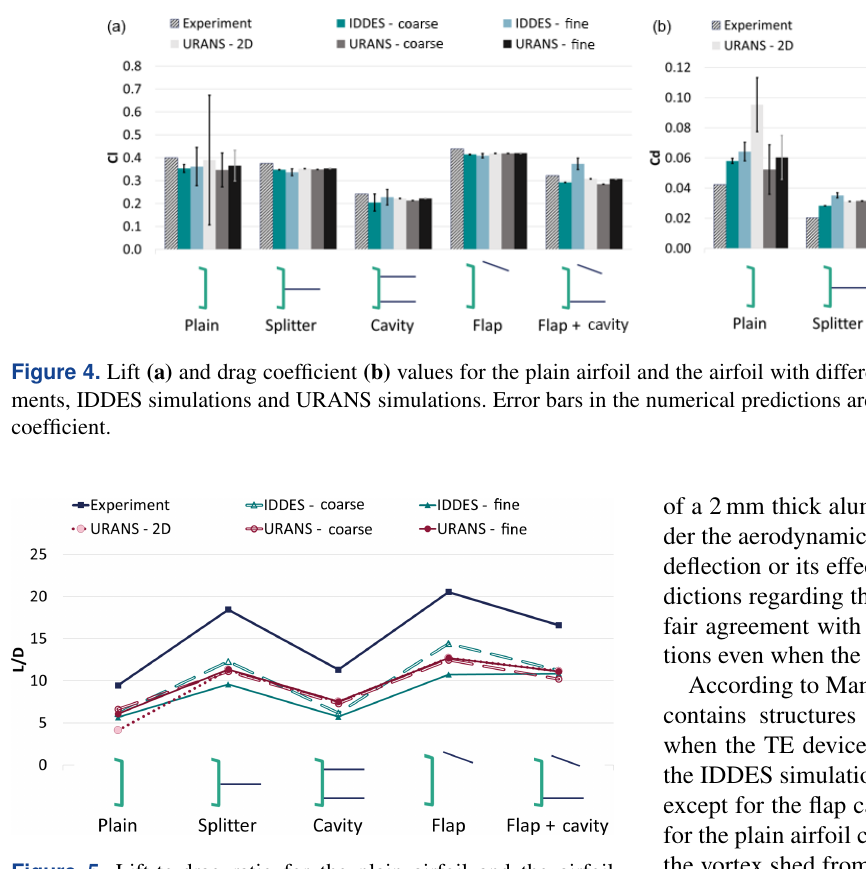
Figure 5. Lift-to-drag ratio for the plain airfoil and the airfoil with different TE devices: comparison between experiments, ID- DES simulations and URANS